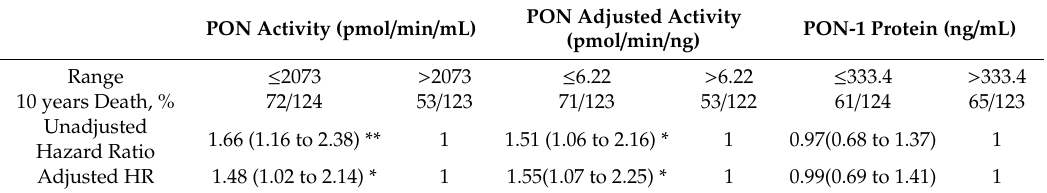
PON Activity (pmol / min / mL)